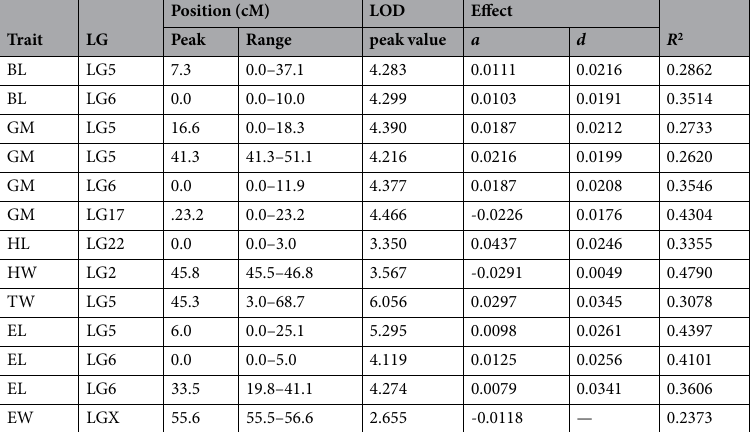
Table 2. Significant QTLs for body size dimensions. Trait: body size dimensions, which were log10-transformed and sex-adjusted. LG: linkage group. Effect: a , additive; d , dominance. R 2 , proportion of variance